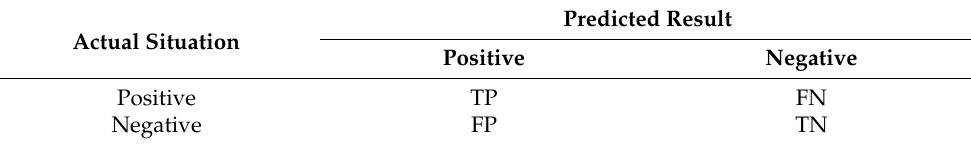
Table 1. Confusion matrix for a binary classification problem [37]. Actual Situation